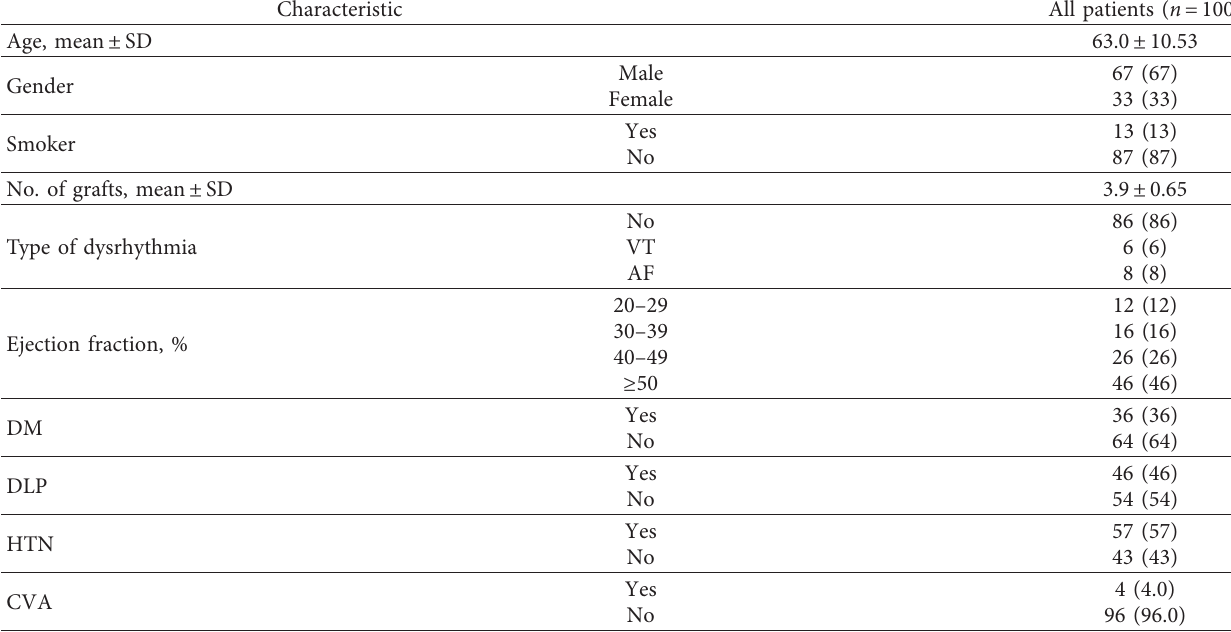
Table 1: The demographic and medical characteristics of the 100 patients participated in the